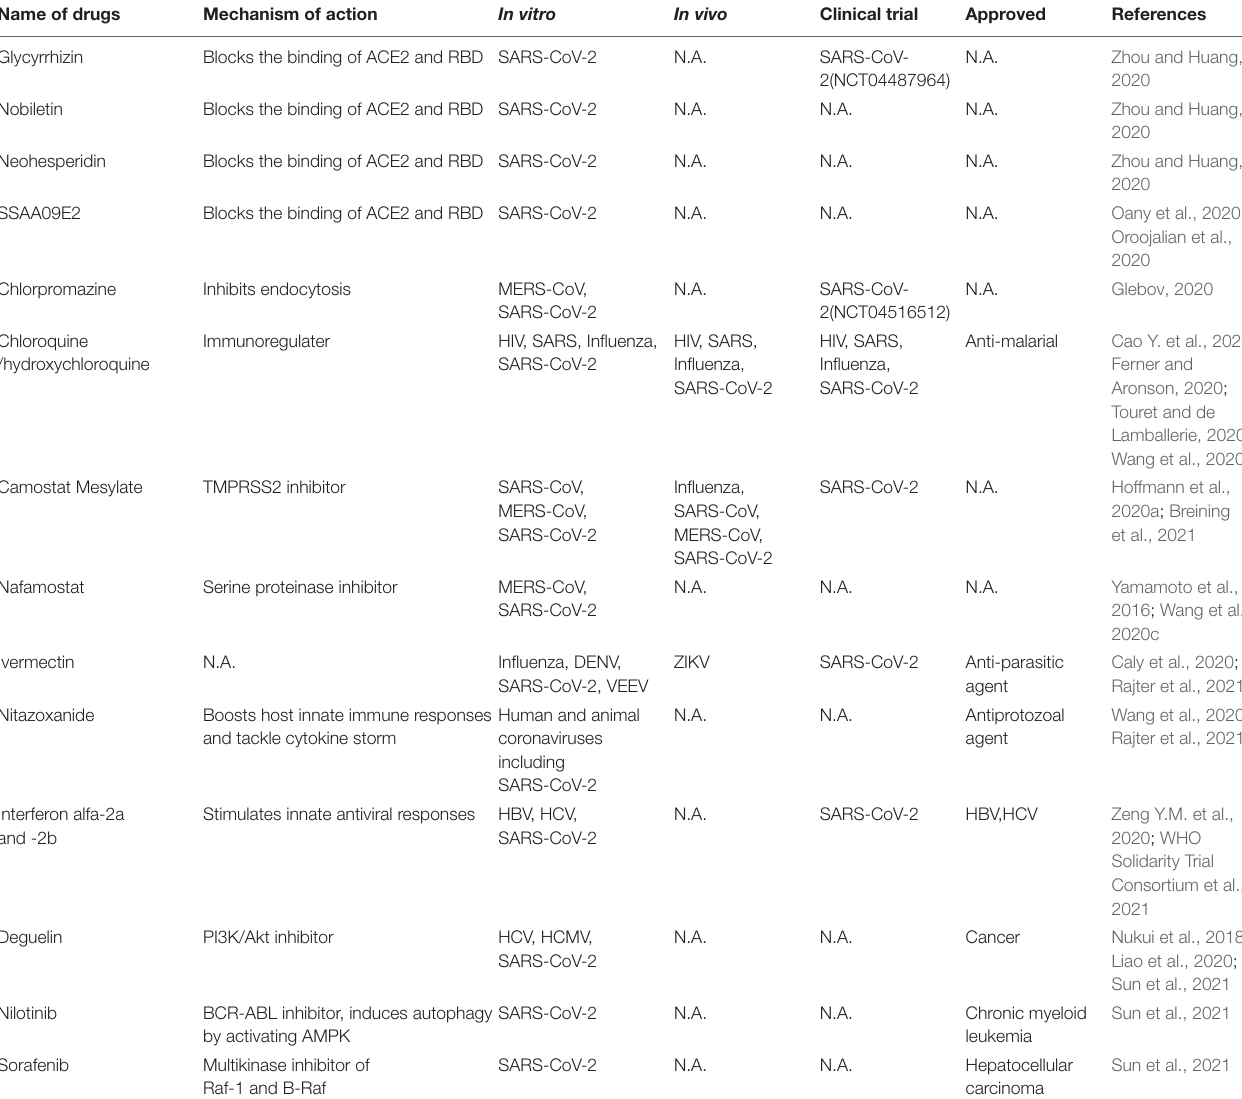
TABLE 2 | Representative host-targeting antivirals for CoV